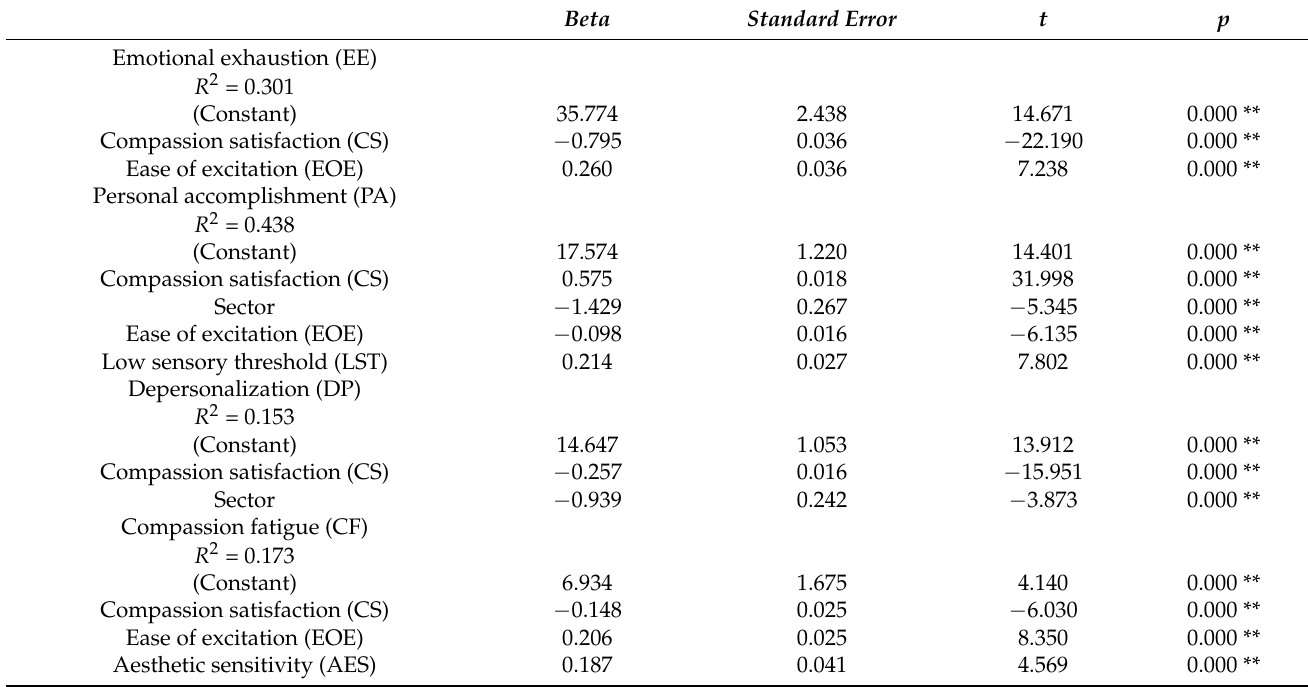
Table 4. Regression analyses. Influence of high sensitivity and compassion satisfaction on burnout dimensions and compassion